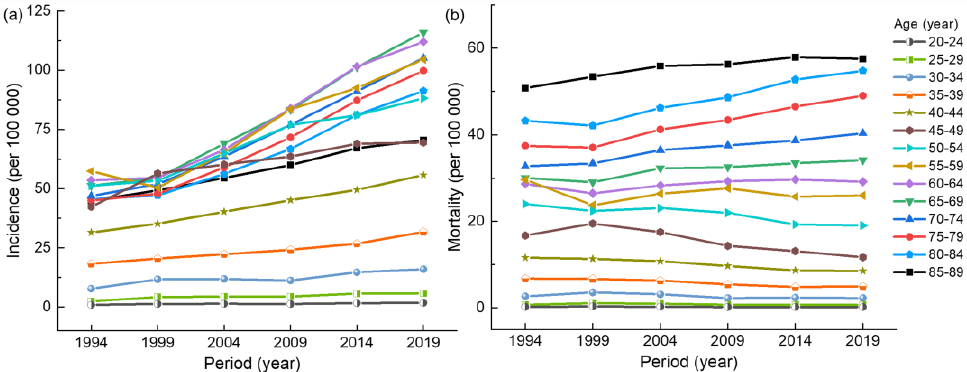
Figure 2. ( a ) Period trend of the incidence of breast cancer in Chinese women. ( b ) Period trend of the mortality breast of cancer in Chinese women.